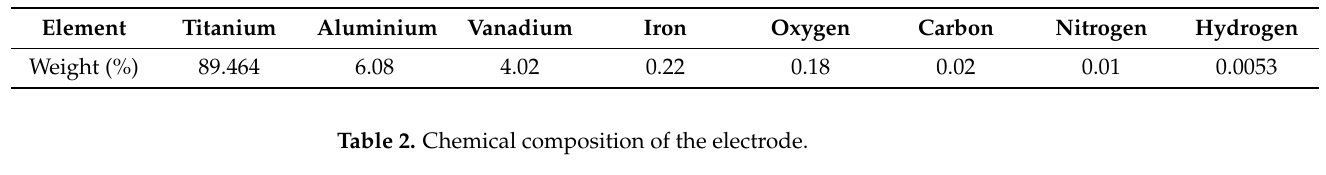
Table 1. Chemical composition of the substrate.